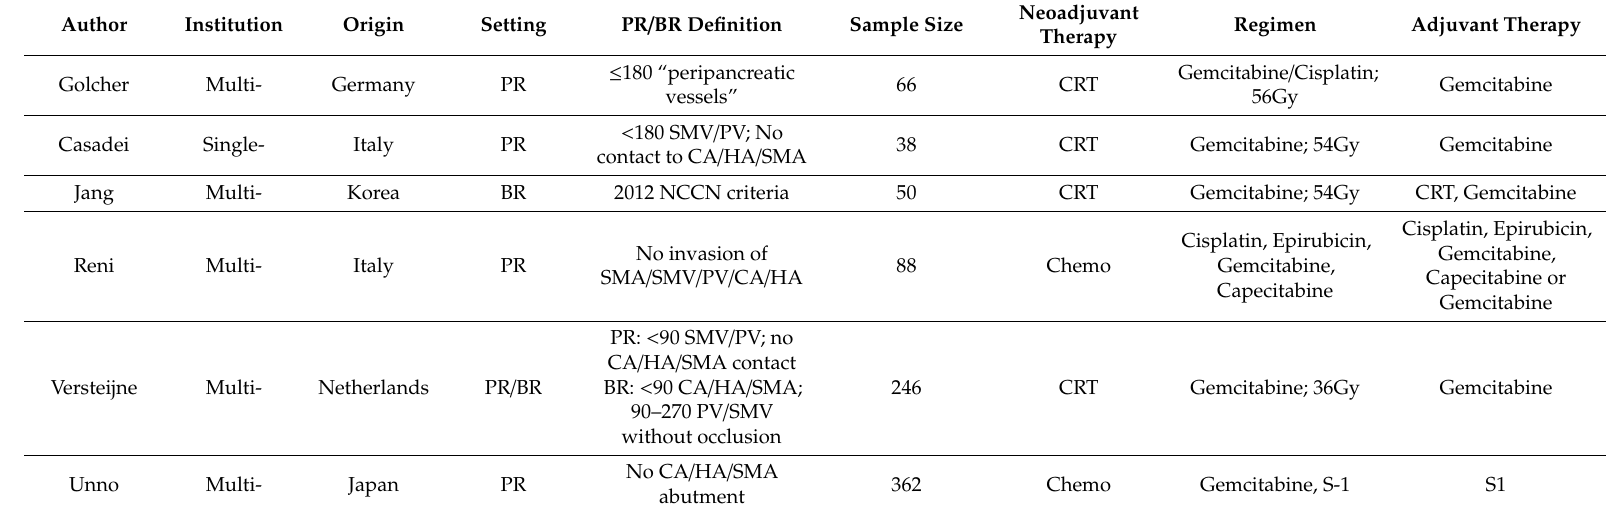
Table 1. Study characteristics for randomized controlled trials included in the